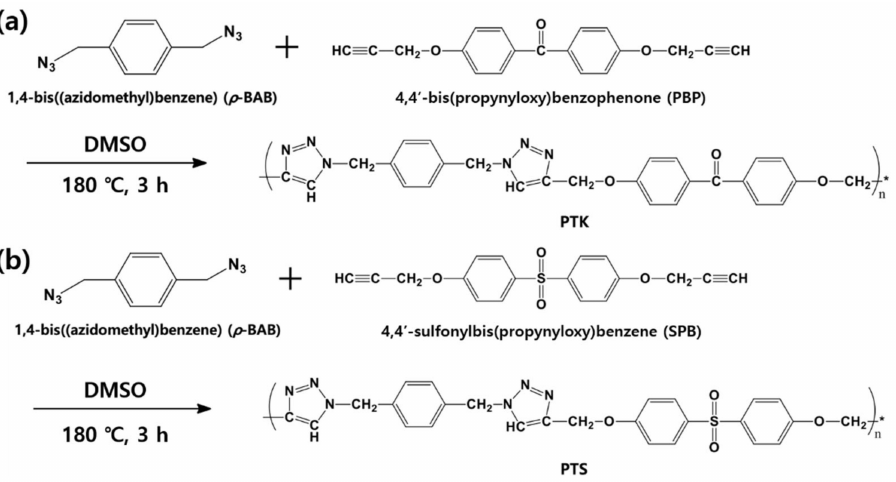
Figure 1. Reaction schemes of ( a ) PTK and ( b )